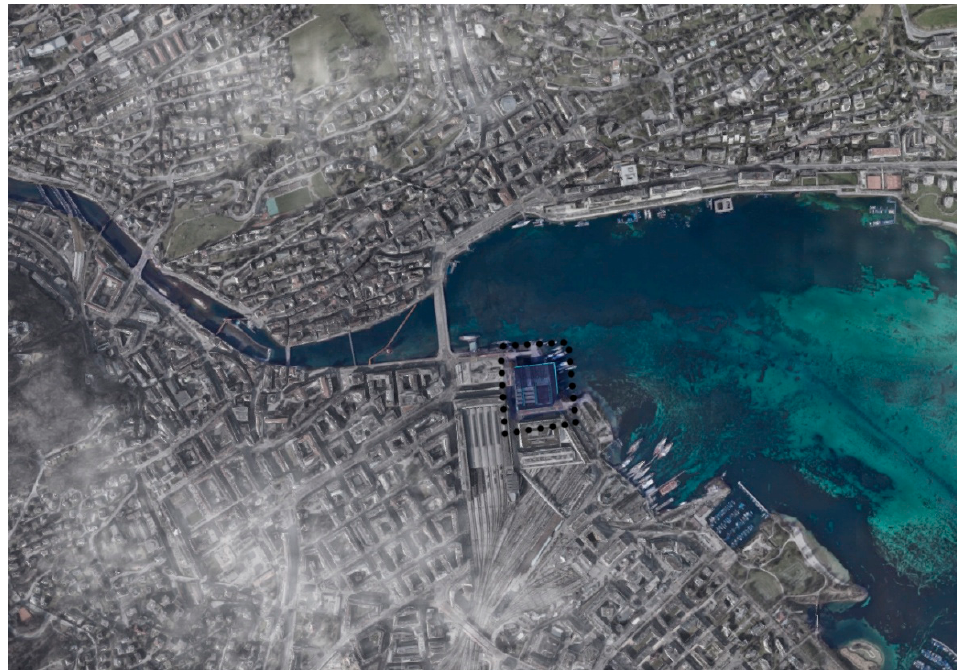
Figure 7. Location of Kultur- und Kongresszentrum Luzern in the city of Lucerne, Switzerland, graphic processing by E. Latusek.